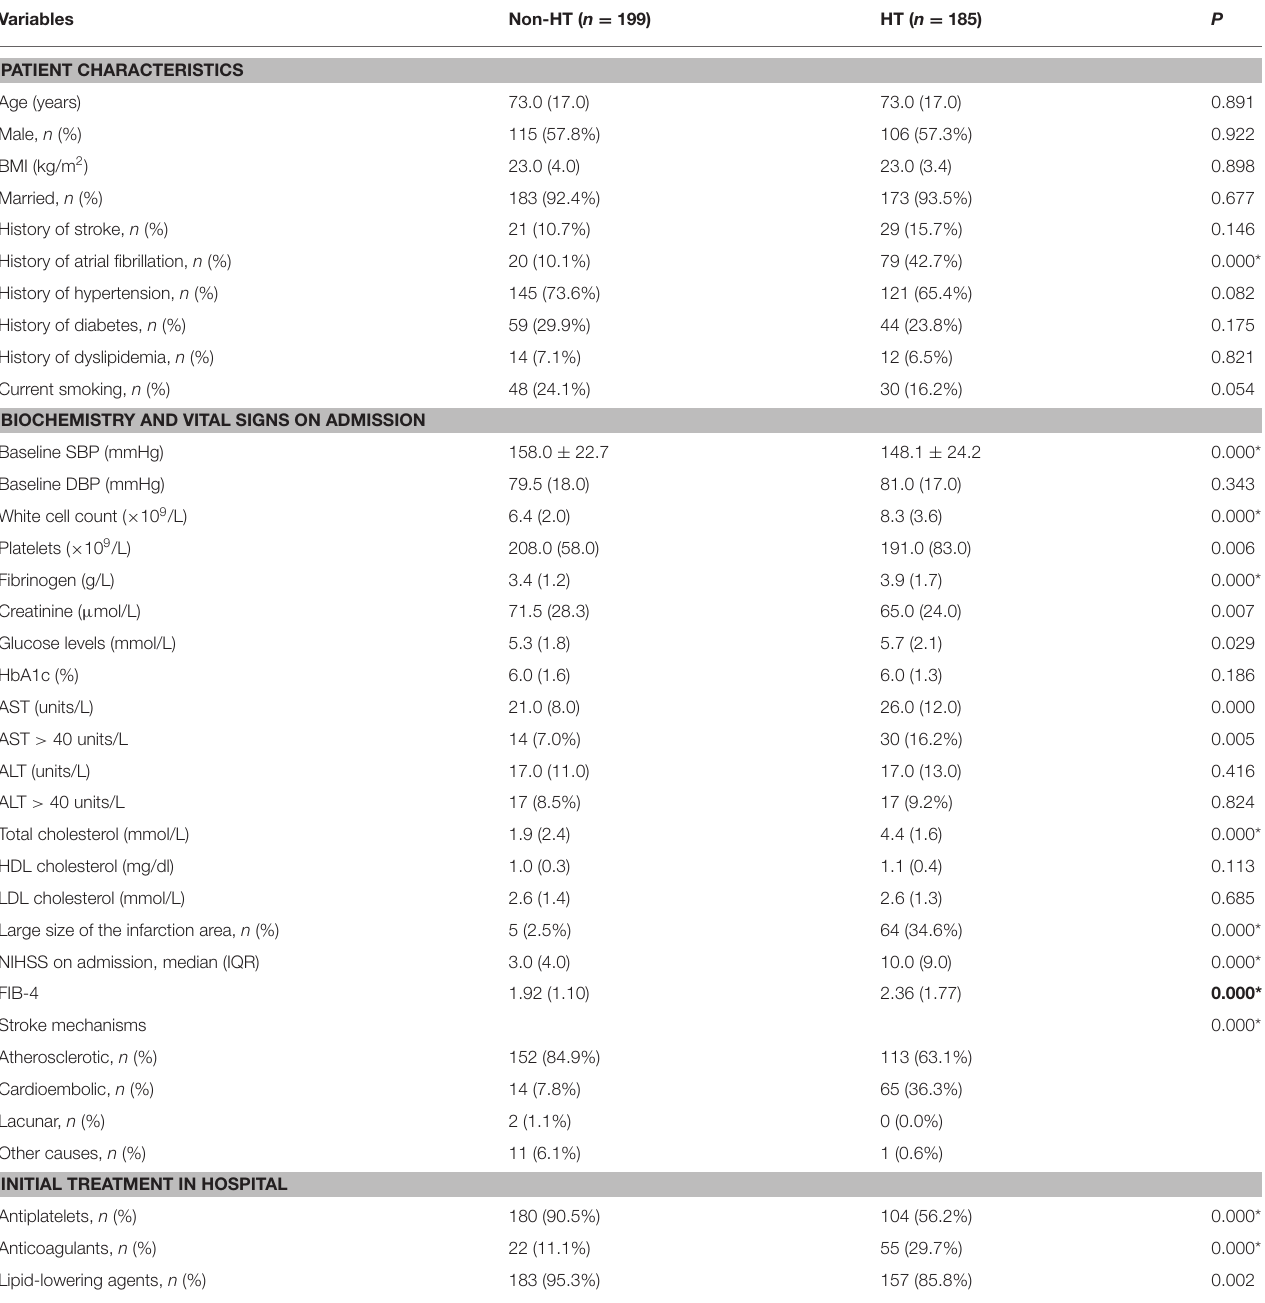
TABLE 1 | Baseline characteristics of AIS patients with and without HT.